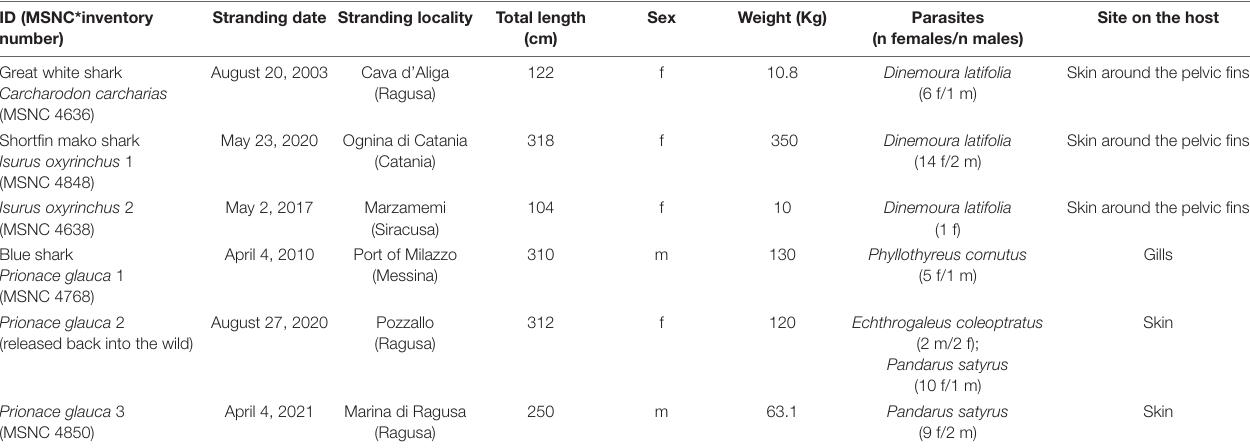
TABLE 1 | Available data of shark individuals examined for pandarid copepods from the coast of